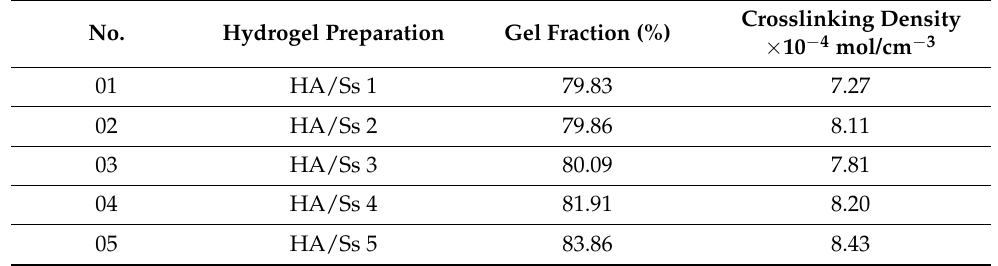
Table 2. Gel fraction and crosslinking density of